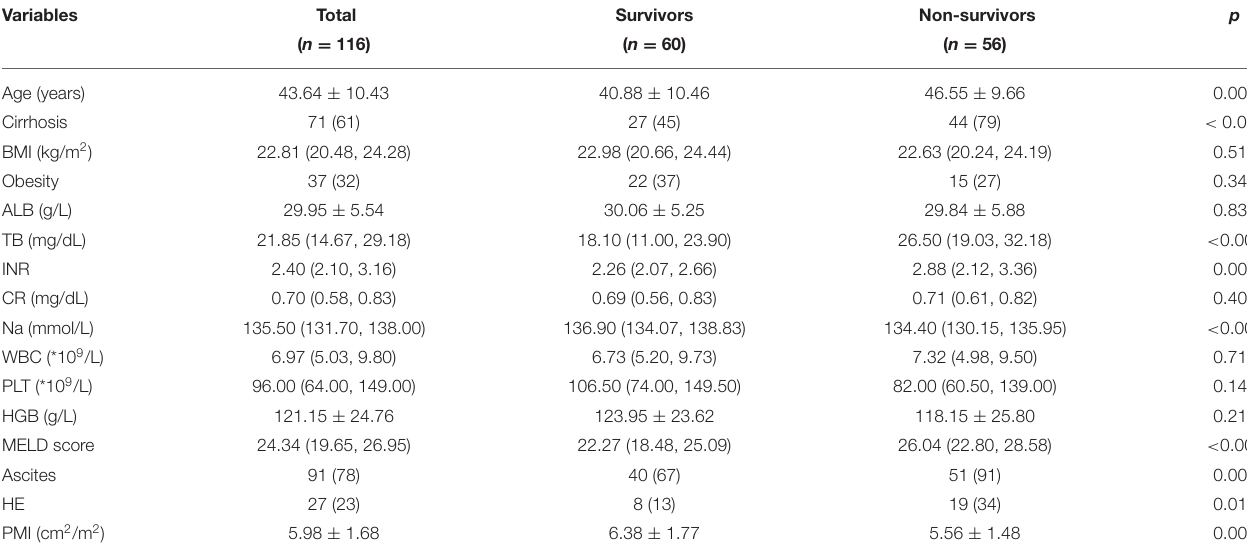
TABLE 1 | Baseline characteristics of surviving vs. non surviving patients in male acute-on-chronic liver failure.